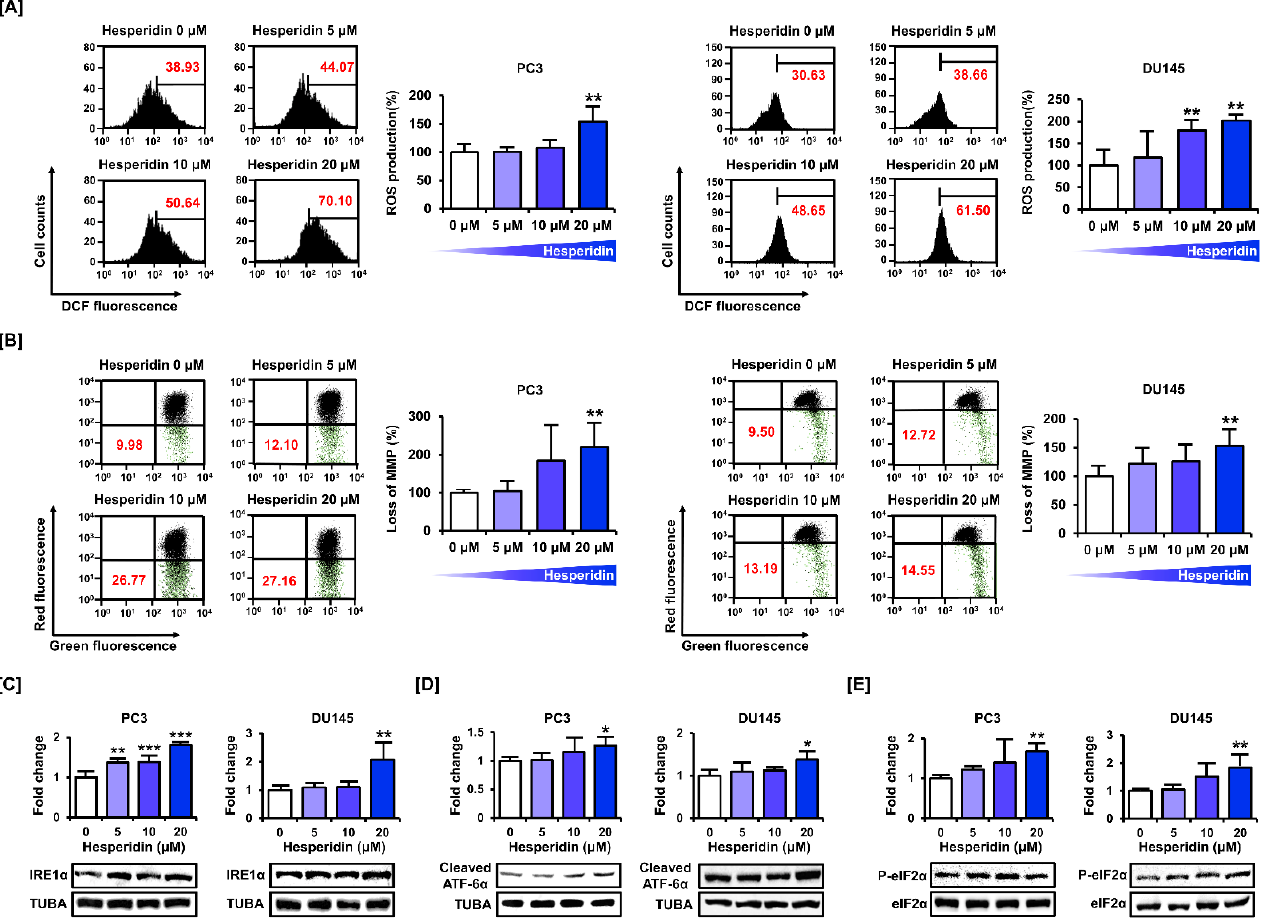
Figure 3. Effect of hesperidin on mitochondrial dysfunction in prostate cancer cells. ( A ) Reactive oxygen species (ROS) generation was estimated based on DCF fluorescence intensity in PC3 and DU145 cells. ( B ) Mitochondrial membrane potential (MMP) was measured in PC3 and DU145 cells after staining with JC-1 dye. ( C – E ) Protein expression levels of inositol- requiring enzyme 1α (IRE1α) ( C ) , cleaved activating transcription factor 6α (ATF6α) ( D ), phosphorylated eukaryotic initiation factor 2α (peIF2α) ( E ) were analyzed via immunoblotting in PC3 and DU145 cells after hesperidin treatment for 24 h in a dose- dependent manner (0, 5, 10, and 20 μM). All results of the arithmetic mean ( n = 3) denote statistical significance with asterisks (* p < 0.05, ** p < 0.01, and *** p < 0.001).